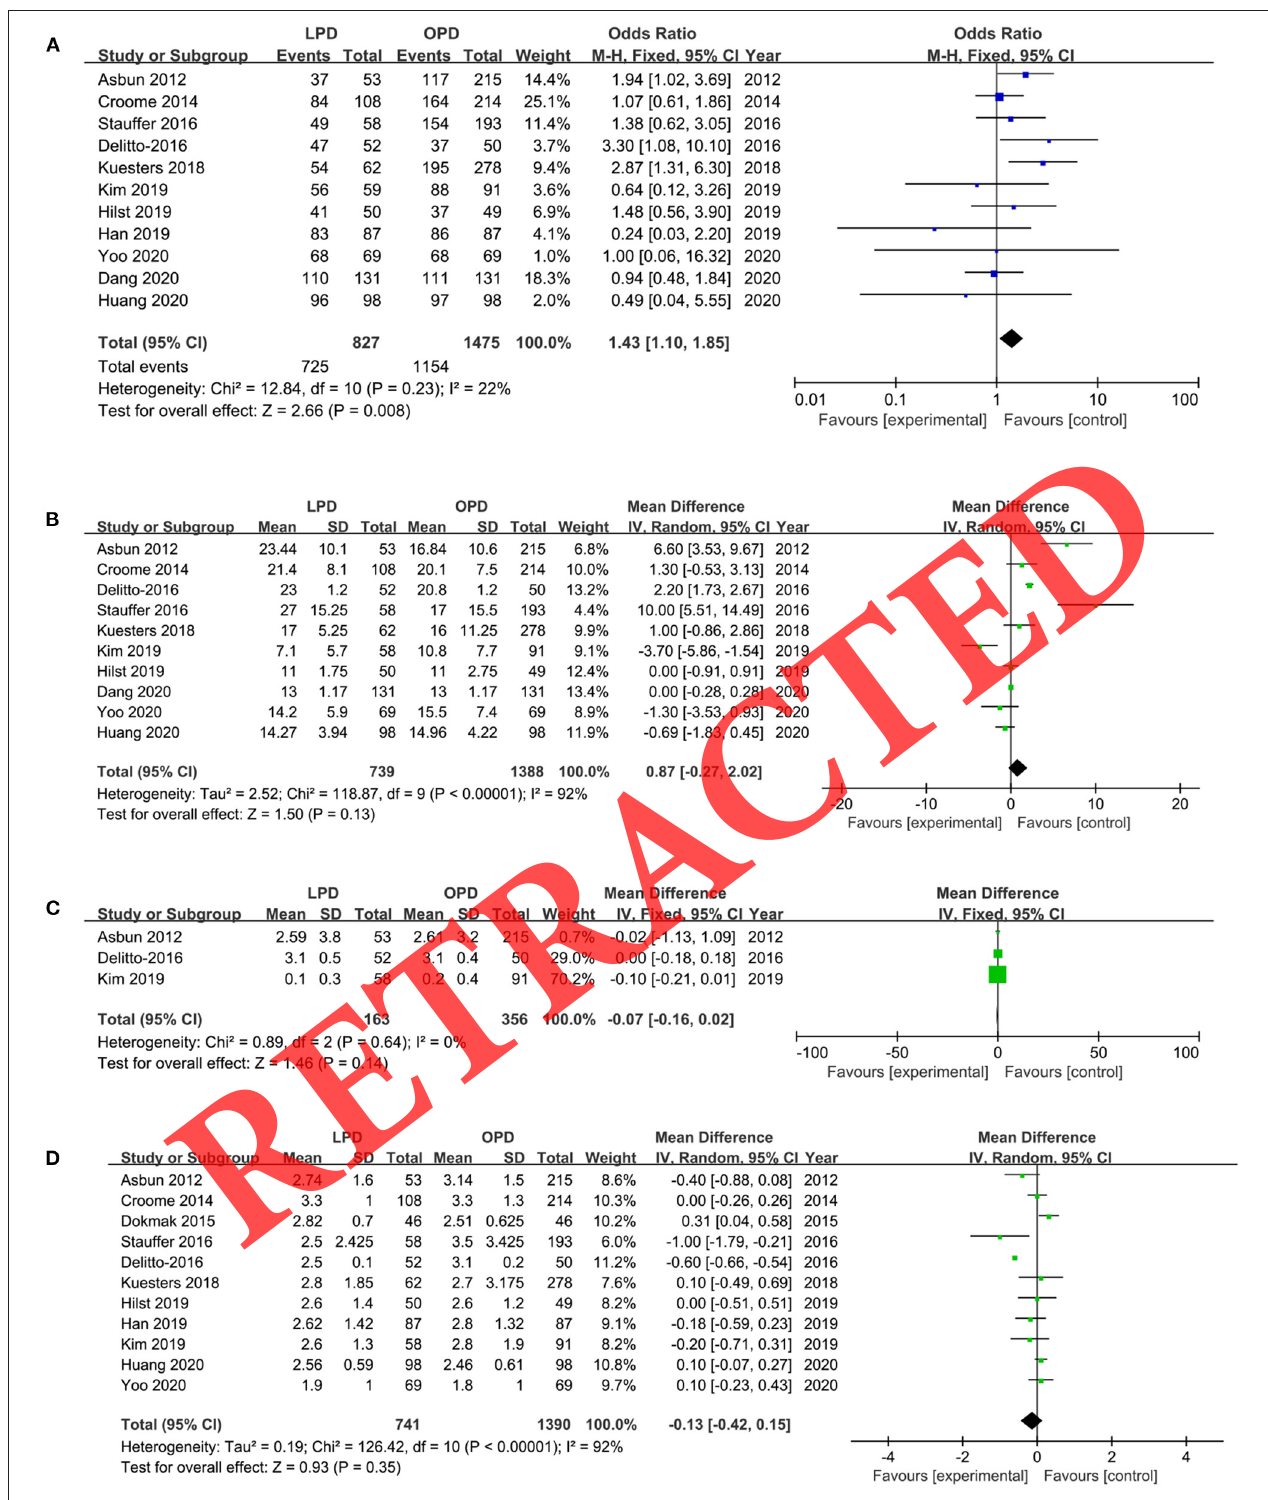
FIGURE 6 | Forest plot of comparison of LPD vs. OPD for short-term oncological outcomes. (A) Forest plot for R0 resection rate; (B) forest plot for lymph node dissection; (C) forest plot for positive lymph node number; and (D) forest plot for tumor size.